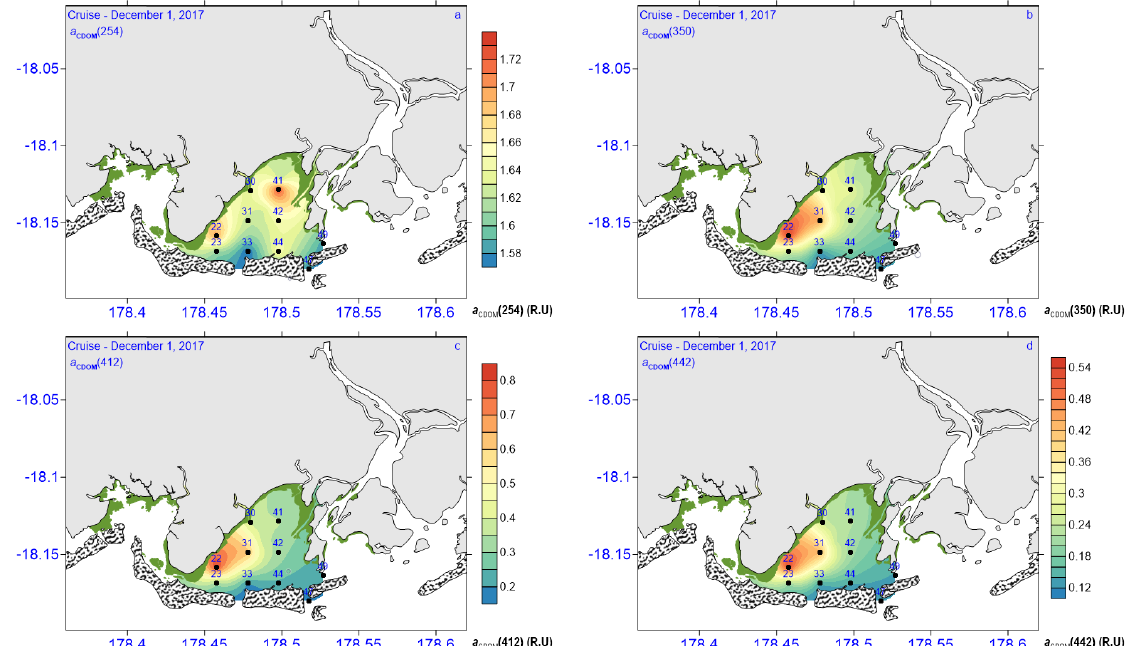
Figure 7. Color maps for absorption coefficients: ( a ) 254 nm ; ( b ) 350 nm; ( c ) 412 nm and ( d ) 442 nm. Distinctively, C1, C2, and C4 fluorescent components presented similar maps (Figure 8a,b,d), and recorded higher values at the west coast of the LBW near the vicinity of the mouths of Uluituni Creek and Samabula River. C3 presented a slightly different distribu ‐ tion in the South West of Laucala Bay with a lower value in front of Uluituni Creek. Lower values were recorded at the OB region within the reef edges and into the POW. Several identical distribution patterns were identified, one for the fluorescent components C2 and C4 (Figure 8b,d; Figure 6 o,q) displaying a higher concentration within the CO (mean val ‐ ues 0.15 ± 0.1 and 0.15 ± 0.09 01 R.U.) and IB (mean values 0.14 ± 0.06 and 0.14 ± 0.01 R.U.)